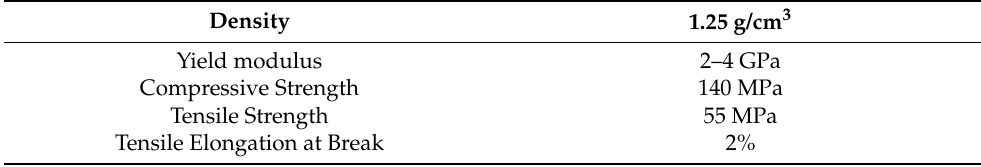
Table 1. The physical properties of the used polyester resin.